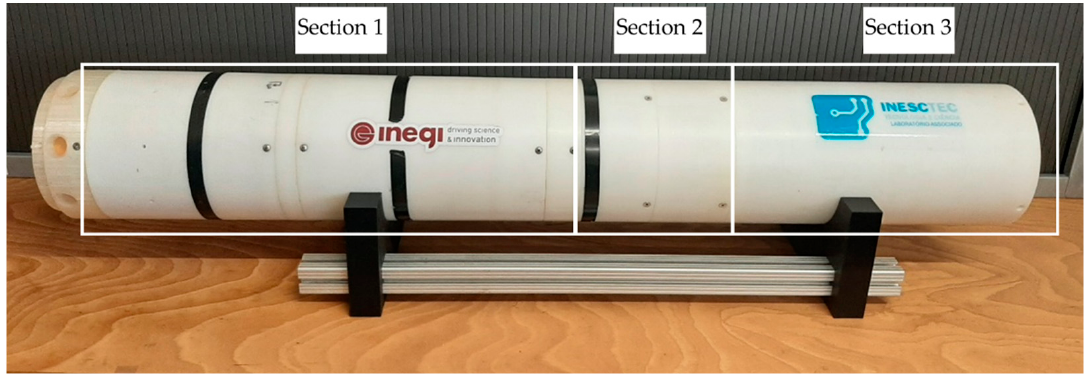
Figure 2. Picture of the developed prototype.